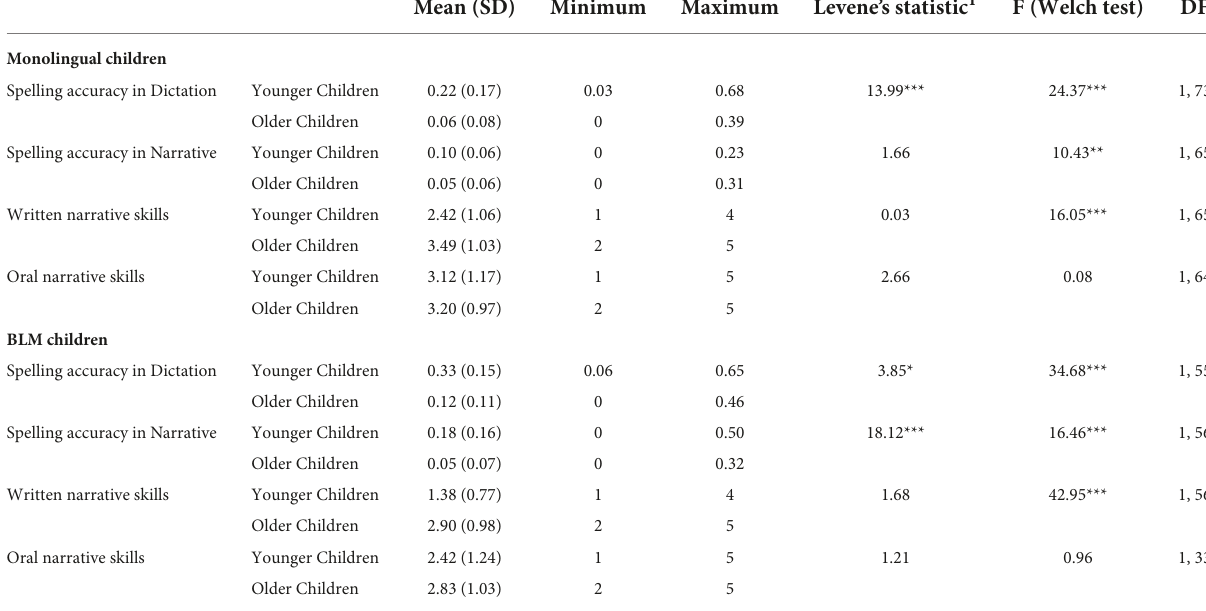
TABLE 2 Descriptive analyses and one-way ANOVA and ANOVA with robust methods results for monolingual and BLM children at school level.